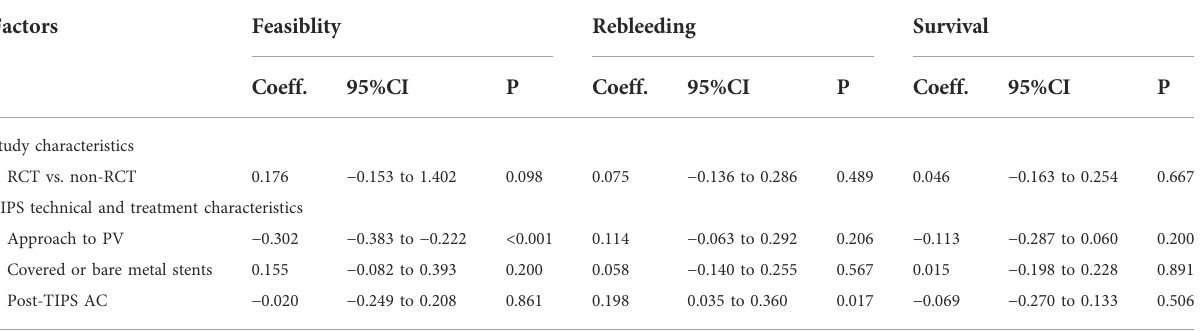
TABLE 4 Meta-regression analysis according to